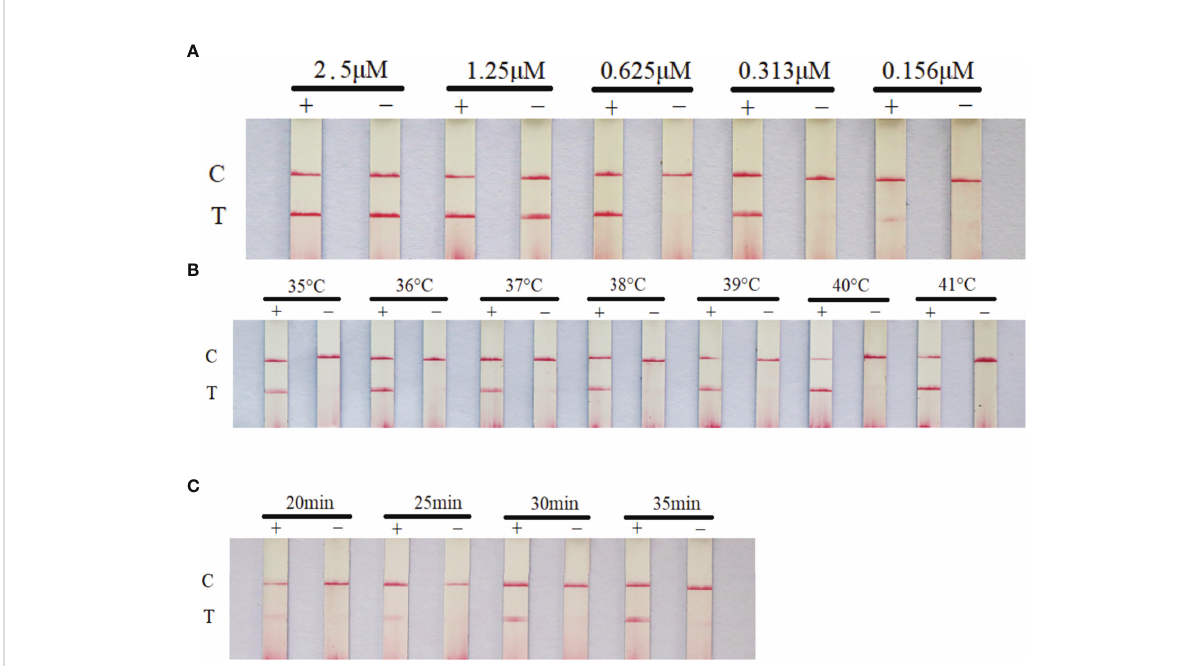
FIGURE 3 Optimization of RAA-LFD reaction conditions. The optimal primer concentration was 0.625 m M, the reaction temperature was 40°C and the reaction time was 30 min. (A) screening of primer and probe concentration; (B) screening of reaction temperature; (C) screening of reaction